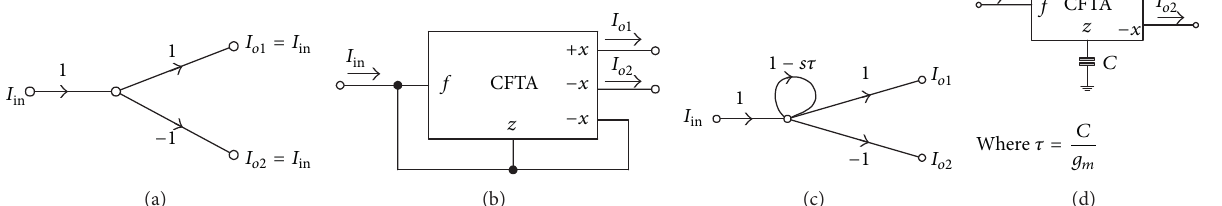
Figure 4: Subgraphs of Figure 3 and their corresponding active- C subcircuit involving